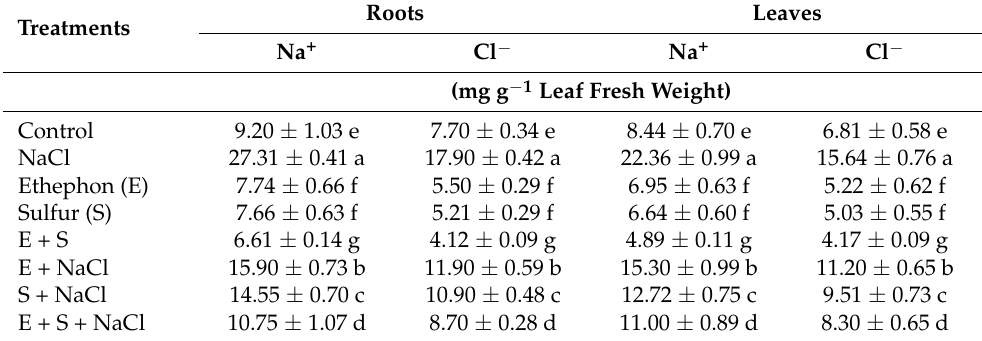
Table 1. Content of Na + and Cl − in roots and leaves of mustard plants at 30 days after sowing. Plants were treated with 200 µ L L − 1 ethephon and/or 200 mg S kg − 1 soil (S) in presence or absence of 100 mM NaCl. Data are presented as means ± SE ( n = 4). Data followed by same letter are not significantly different by LSD test at p < 0.05. Roots Treatments